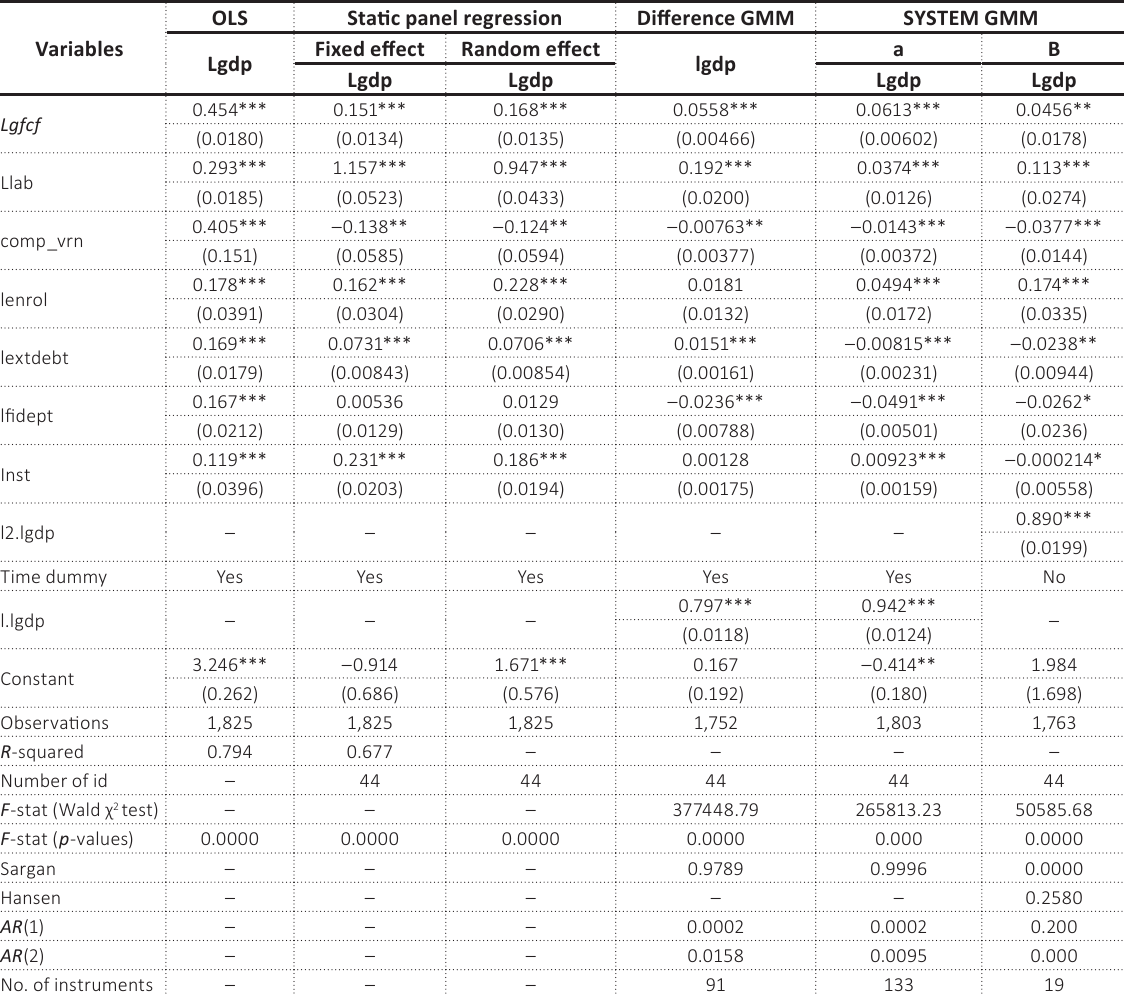
Table 2. Commodity price volatility-growth (control variables) regression